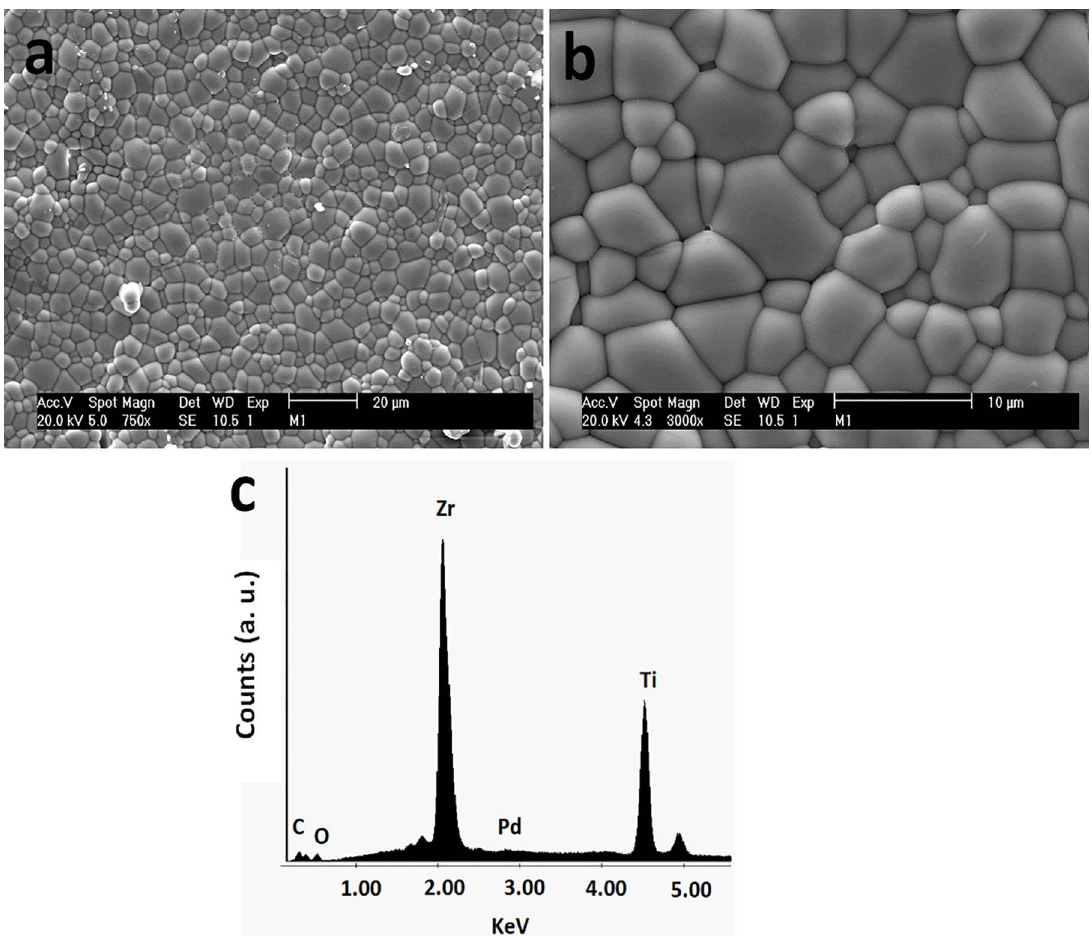
samples Microstructures (a and b) and EDS spectrum 4 :